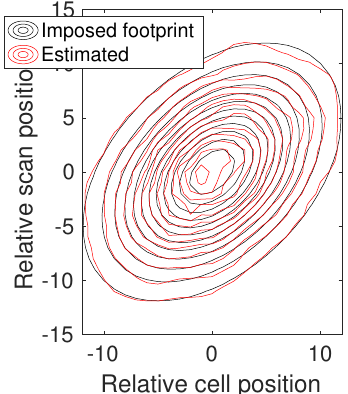
Figure 6. The contour-lines of the imposed footprint (Figure 5a) and the final result shown in Figure